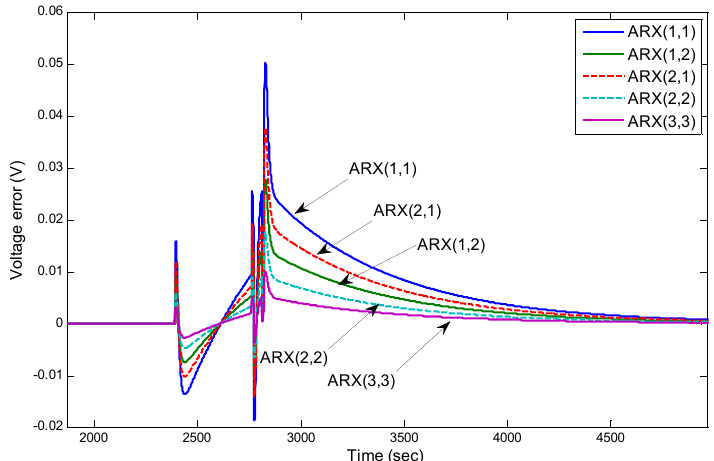
Figure 13. The terminal voltage error curves between the simulation and experiment (enlarged at SOC =